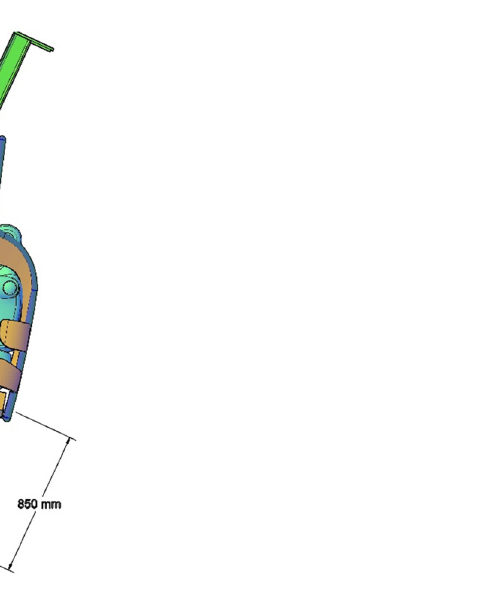
Figure 18. Additional bending moments on the shelter column at t = 152 milliseconds (situation 2).